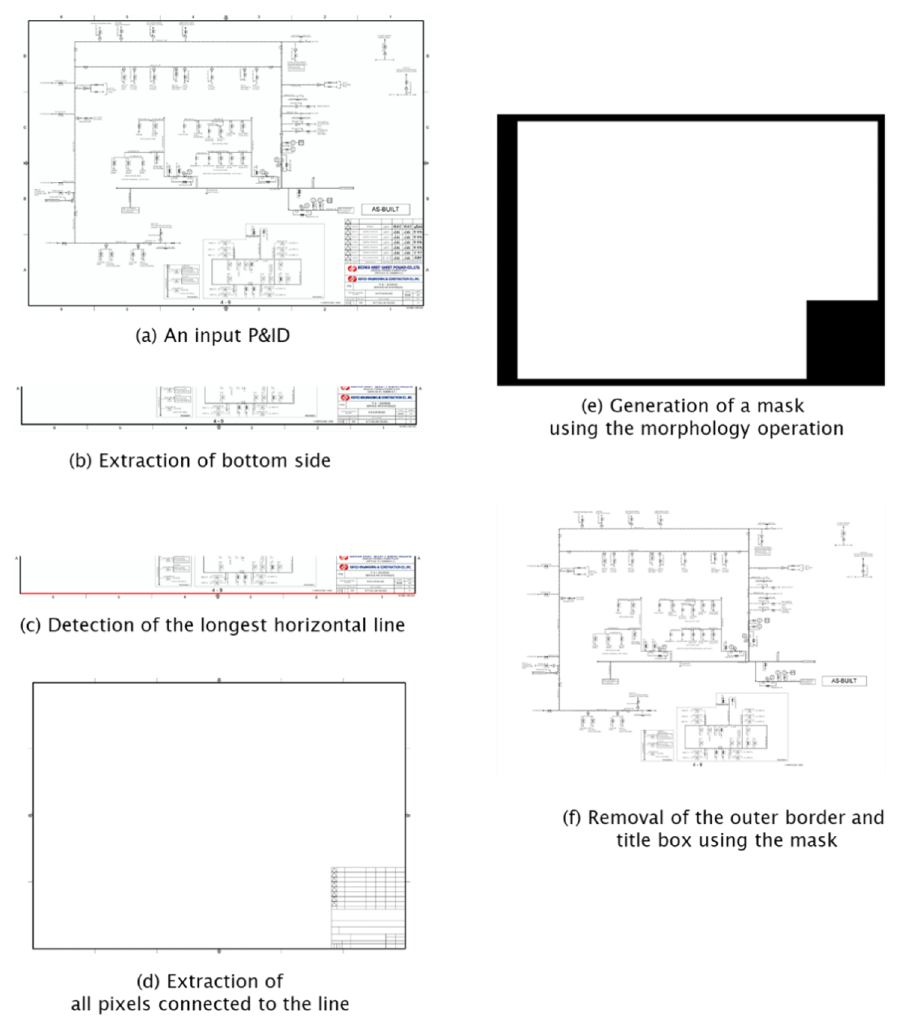
Figure 3. Removal of the outer border and title box in P&ID.